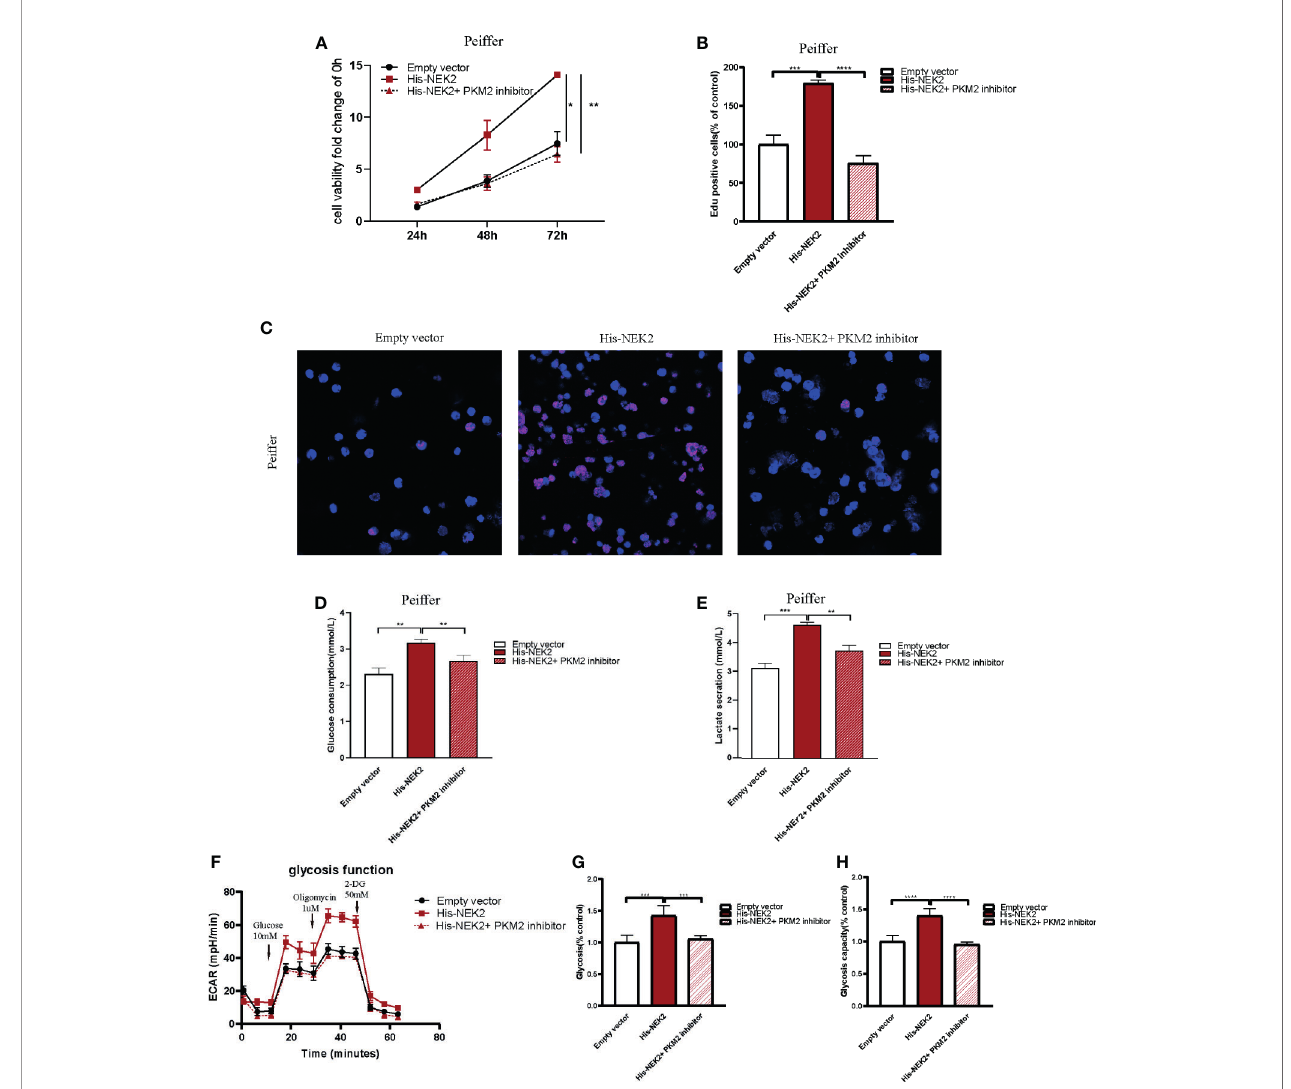
FIGURE 6 | NEK2 enhanced the proliferation and glycolysis of DLBCL cells through PKM2. (A) Cell proliferation curves plotted according to CCK8 assay in three groups, including control group, NEK2 overexpression group and NEK2 overexpression with PKM2 inhibitor group (*P < 0.05, **P < 0.01, Student ’ s t-test); (B, C) histogram statistics of Edu-positive cell rate and representative images of EdU staining in three groups, including control group, NEK2 overexpression group and NEK2 overexpression with PKM2 inhibitor group (***P < 0.001, ****P < 0.0001, Student ’ s t-test); (D, E) Overexpression of NEK2 signi fi cantly increased the glucose uptake and lactate production of Peiffer cells while PKM2 inhibitor abrogated the promoting effects of NEK2 on the glycolysis of Peiffer cells (**P < 0.01, ***P < 0.001, Student ’ s t-test). (F – H) ECAR results in three groups, including control group, NEK2 overexpression group and NEK2 overexpression with PKM2 inhibitor group. Overexpression of NEK2 signi fi cantly increased the glycolytic rate and glycolytic capacity of Peiffer cells while PKM2 inhibitor abrogated the promoting effects of NEK2 on the glycolysis of Peiffer cells (***P < 0.001, ****P < 0.0001, Student ’ s